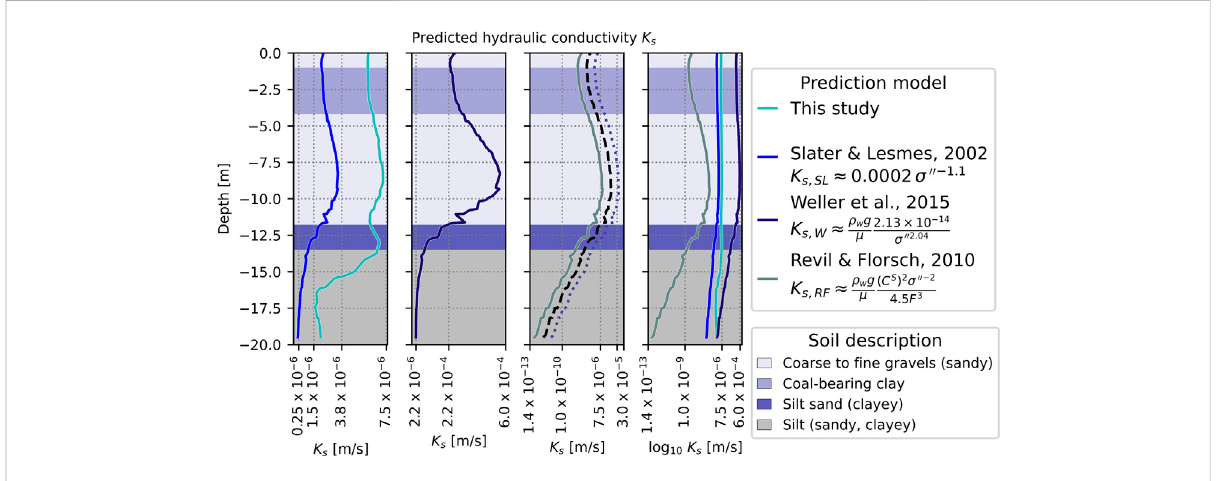
FIGURE 13 Predicted hydraulic conductivity K s using our approach(cyan)and the relationshipsby Slater and Lesmes (2002) (blue), Weller et al. (2015) (dark blue) and Revil and Florsch (2010). The dotted, dashed and solid line refer to formation factors computed for fl uid conductivity values of 19, 35, and 60 mS/m. The color-coded backgrounds indicate the textural